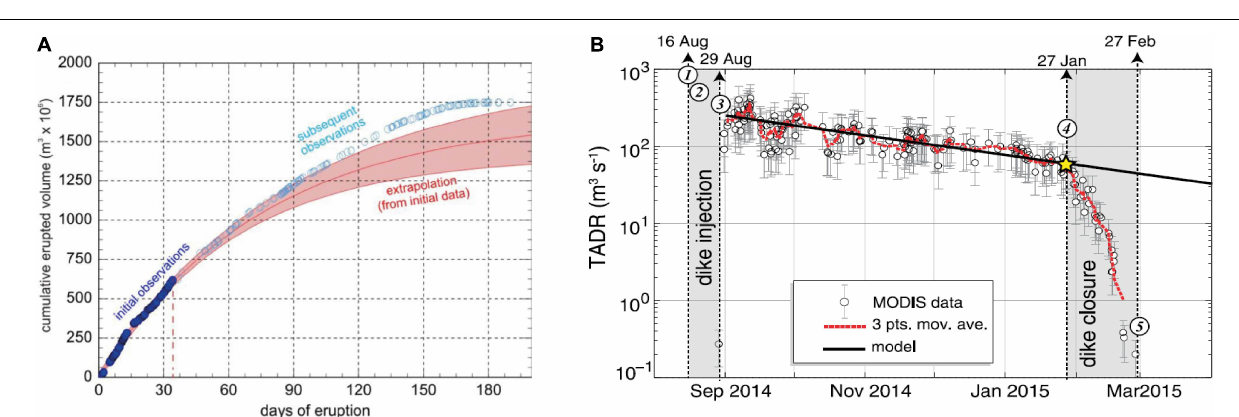
FIGURE 8 | (a) Middle Infrared Observations of Volcanic Activity-derived TADR (blue circles) and cumulative volume (red circles) provided to the Observatoire Volcanologique du Piton de la Fournaise (OVPF) during the April 2018 eruption. Q 0 is the initial flow rate, used to model the maximum runout of the emplacing lava flow (modified from Harris et al., 2019). (b) Lava flow inundation map derived from ingestion of MIROVA-derived TADR into DOWNFLOW-PyFLOWGO models. The numbers (in m 3 s − 1 ) next to each star correspond to maximum and minimum estimate of Q 0 measured on 28 April 2018. Overlain are the limits of the flow field defined from InSAR incoherence (blue outline) and field mapping (yellow outline) on the same dates. Background shows the DOWNFLOW inundation area (modified from Harris et al., 2019).